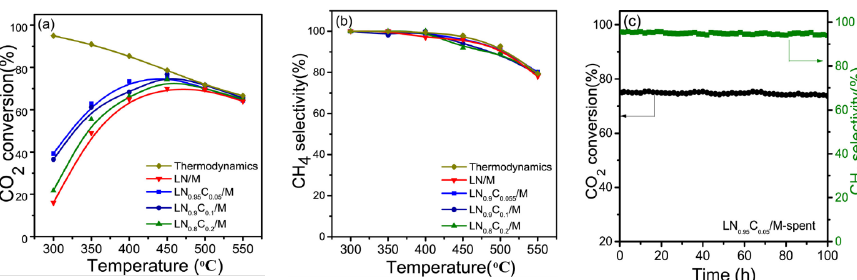
Figure 8. Catalytic properties of the catalysts at 60,000 mL g − 1 h − 1 : ( a ) CO 2 conversion, ( b ) CH 4 selectivity, and ( c ) lifetime test of LN 0.95 C 0.05 /M at 450 °C. Reproduced with permission from [89]. Copyright: Elsevier, Amsterdam, The Netherlands, 2020.